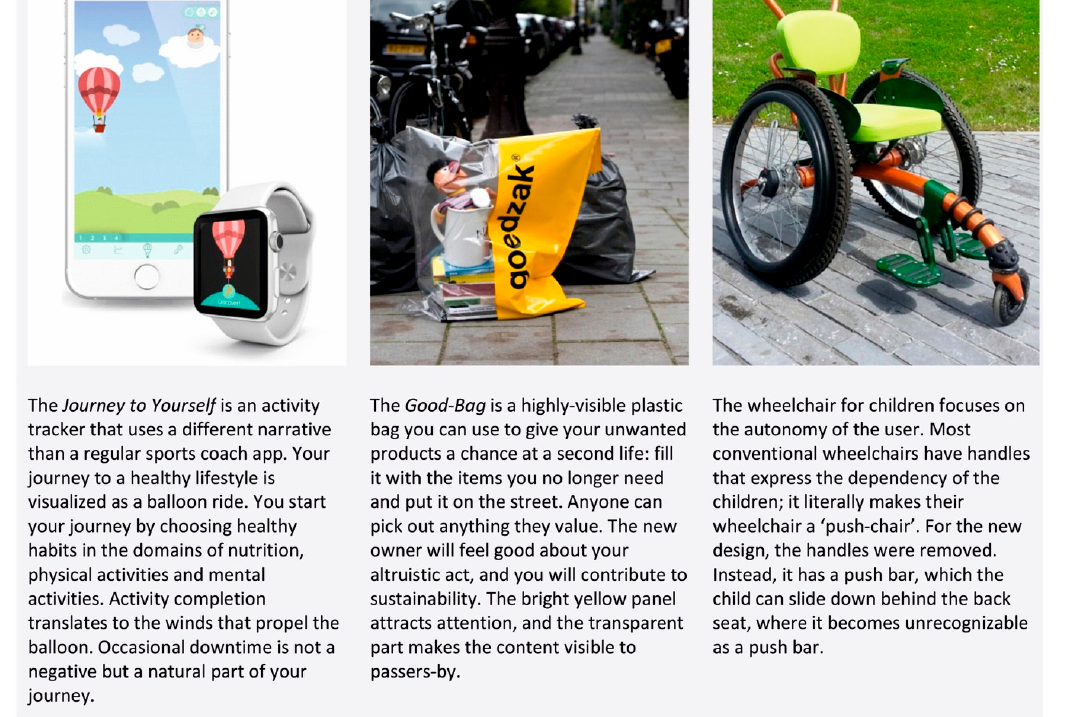
Figure 3. Design cases informed by needs analysis.